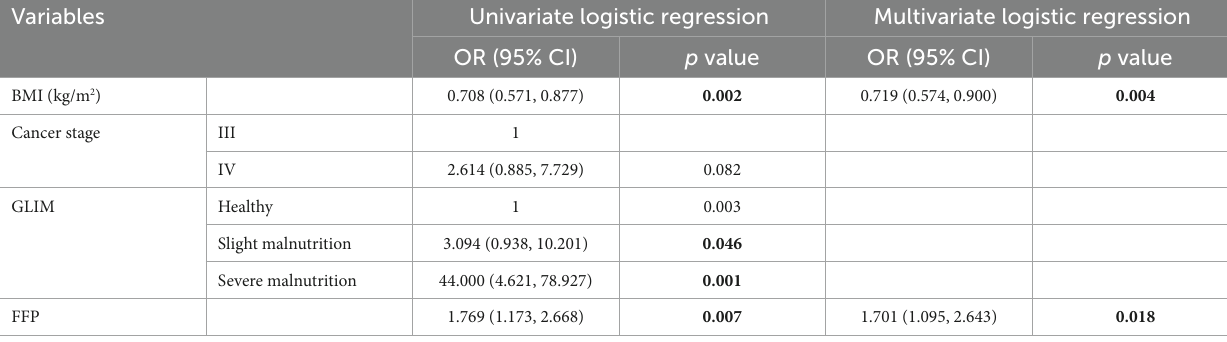
TABLE 7 Univariate and multivariate logistic regression analysis for subjects ≥